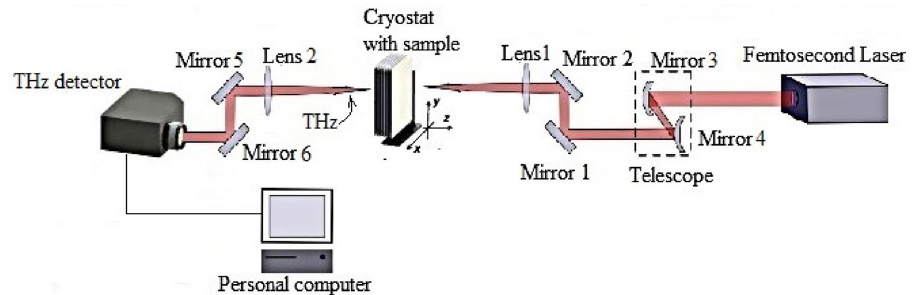
Fig. 3 Scheme of an experi- mental device for recording THz plasmon resonances in samples of InGaN/AlGaN/GaN